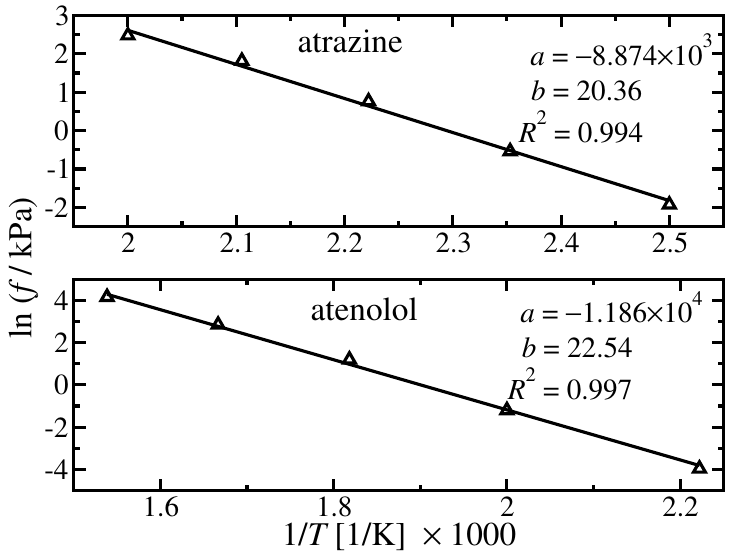
Figure 3. Pure liquid fugacity of atrazine and atenolol. Triangles up are the pure liquid fugacity com- puted using molecular simulation and the solid black line is the Clausius-Clapeyron fit. In all cases we use SM8/CM4 partial atomic charges. The Clausius-Clapeyron parameters and corresponding coefficient of determination ( R 2 ) is provided for each